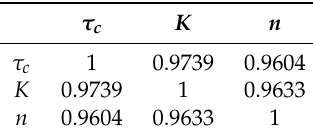
Table 3. The Pearson correlation coefficients between τ c , K , and n